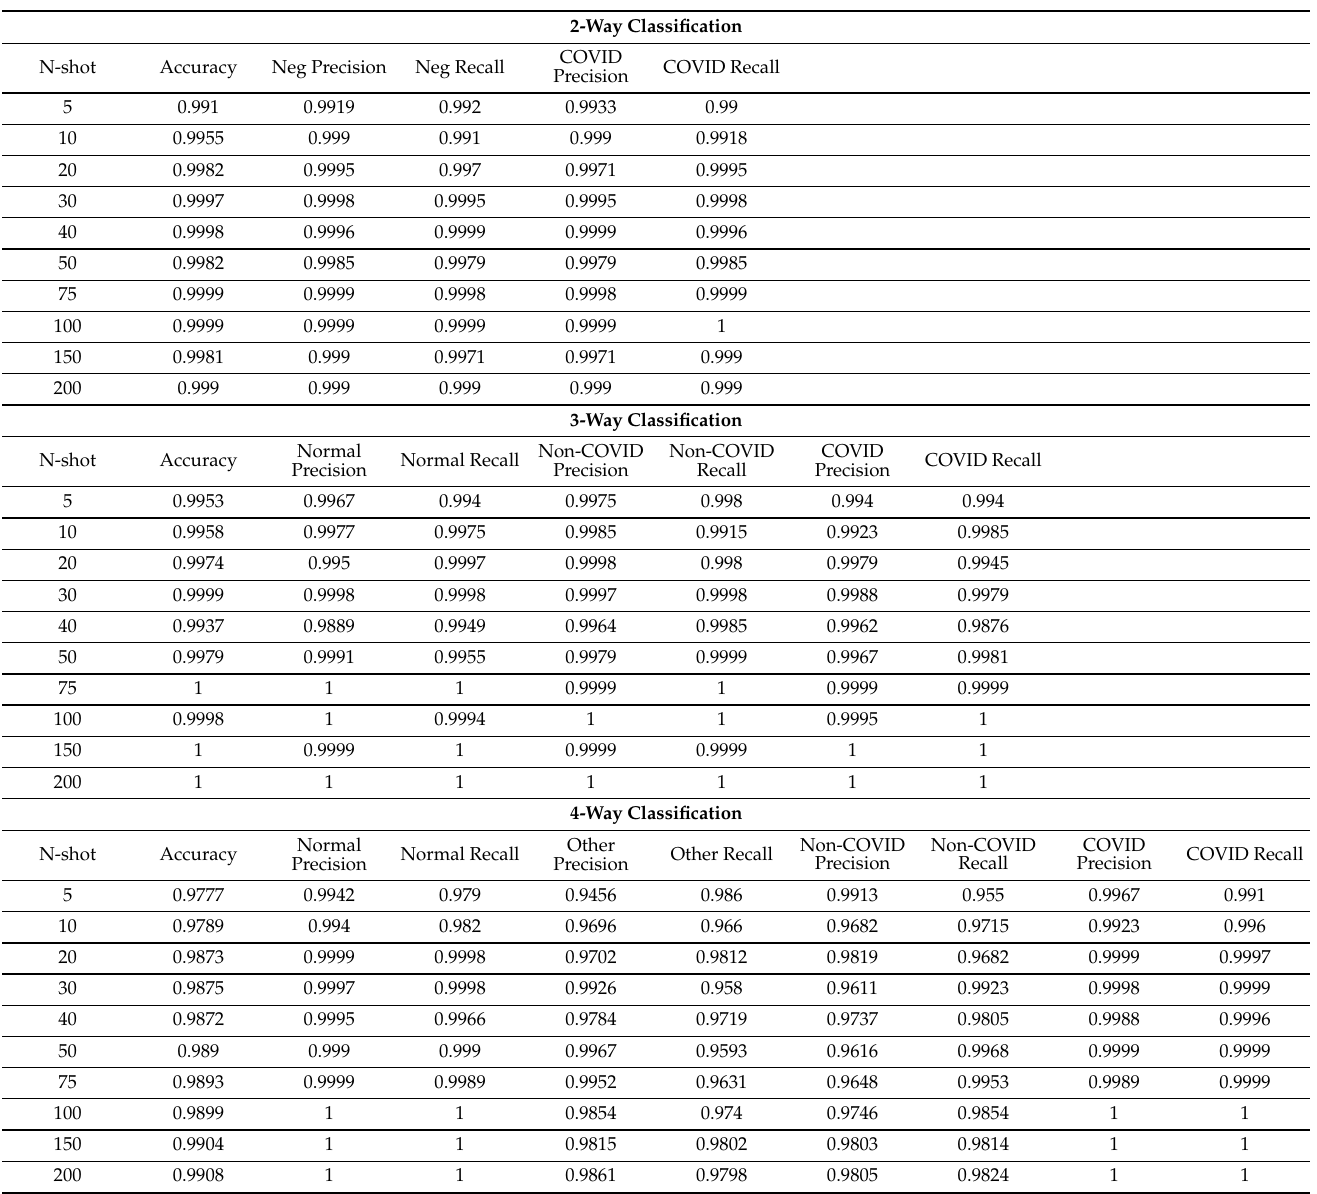
Table A6. Complete experiment results for